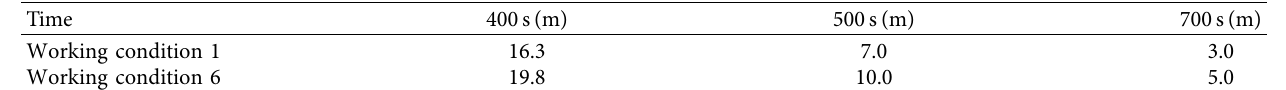
Table 11: Comparison of visibility changes under working conditions 1 and